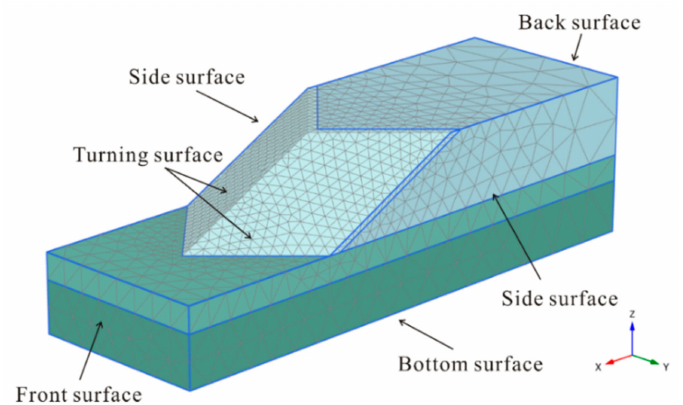
Figure 5. Element distribution in the 3D slope